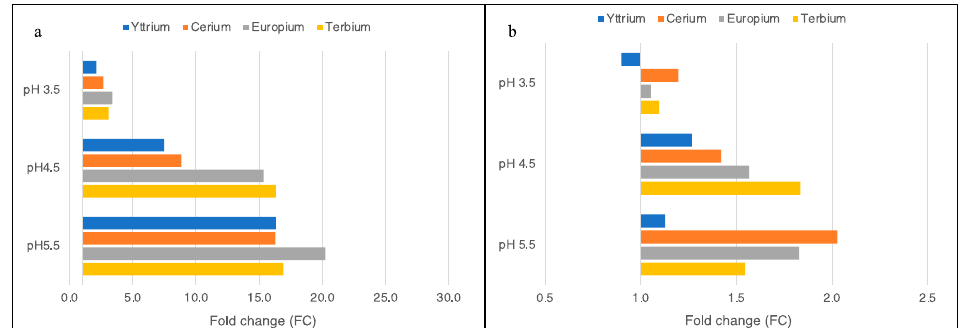
Figure 2. Fold change of the total metal removed from the single-metal aqueous solutions by G. sulphuraria , strains SAG 107.79 ( a ) and ACUF 427 ( b ). The fold change was calculated by comparing the µmol/g dm of every metal obtained at pH 3.5, 4.5, and 5.5 with the µmol/g dm measured at pH 2.5.